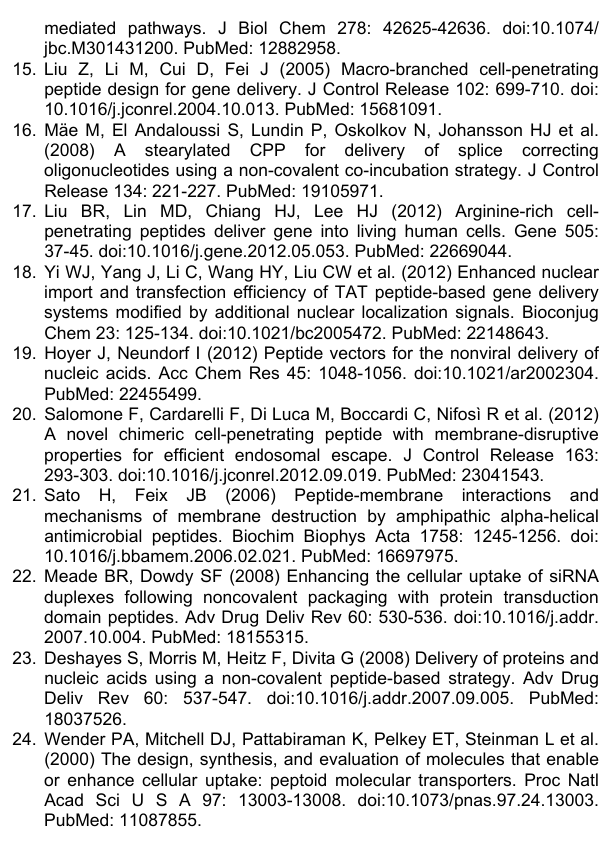
Figure S2. Spectroscopic properties of Cy3-DNA/atto633 complex. Fluorescence spectra are recorded at 37 °C with a